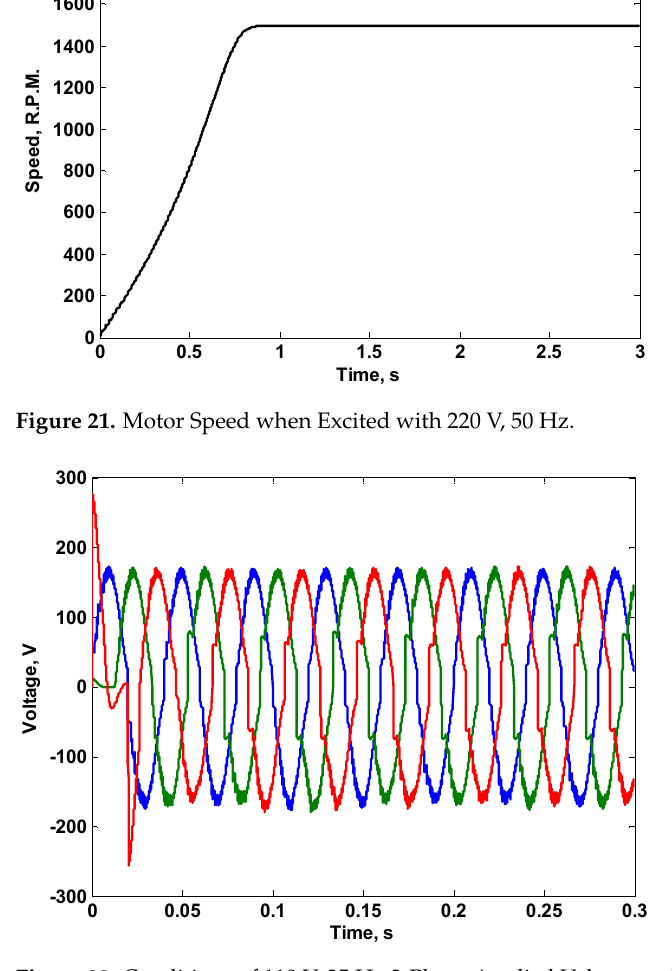
Figure 22. Conditions of 110 V, 25 Hz 3-Phase Applied Voltage at the Motor Terminals.